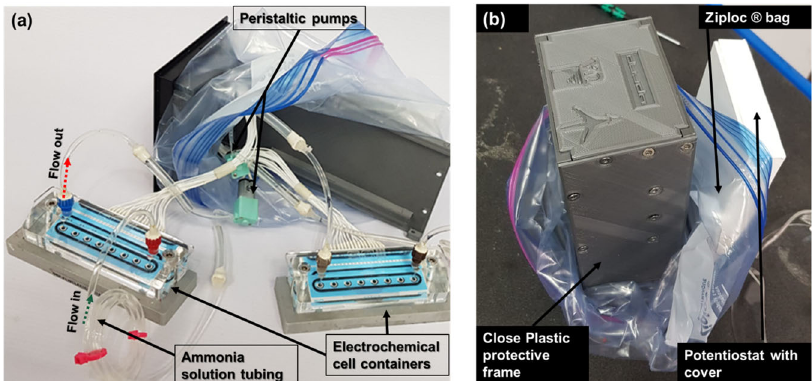
Fig. 5 AELISS ammonia solution fl ow system. a Open device picture showing the two sets of closed loops of ammonia solution inside the protective plastic frame and b the closed device inside the Ziploc ®